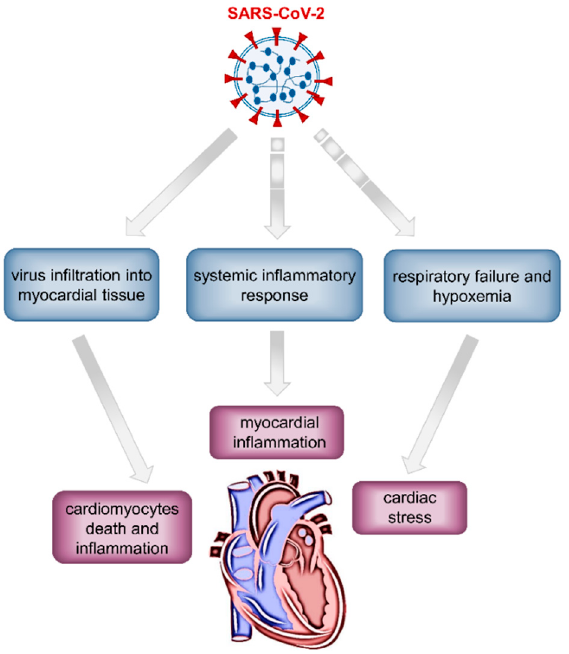
Figure 3. Schematic diagram showing the proposed mechanisms of the severe acute respiratory syndrome coronavirus 2 (SARS-CoV-2)-mediated myocardial injury. The solid arrow indicates a direct mechanism involving virus infiltration into the myocardium, whereas dotted arrows represent indirect mechanisms based on systemic inflammation, respiratory dysfunction, and hypoxemia.